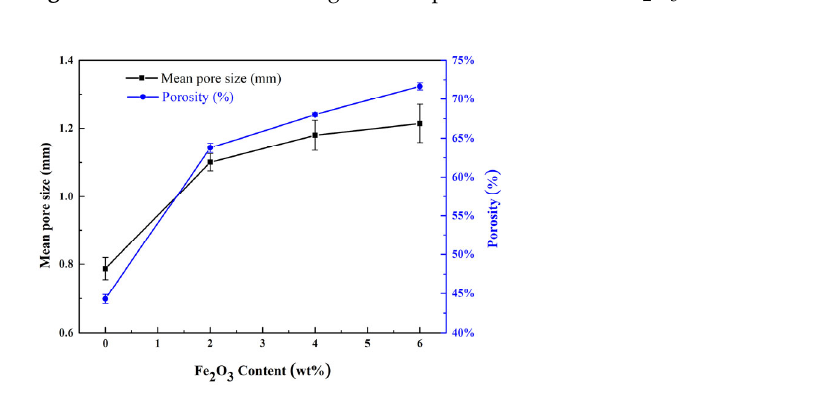
Figure 11. Cross-sectional images of samples with different Fe 2 O 3 contents at 1200 ◦ C for 20 min.